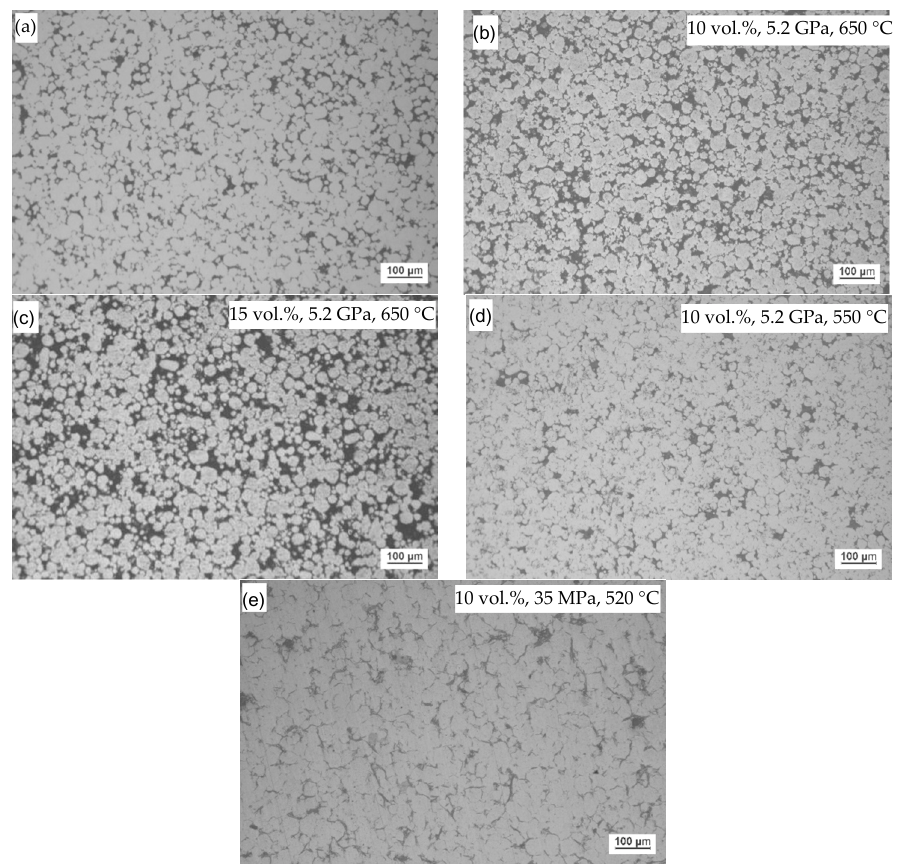
Figure 2. Optical images of the sintered G/6061Al with ( a ) 5 vol.%, ( b ) 10 vol.% and ( c ) 15 vol.% graphite at 5.2 GPa and 650 °C and ( d ) that with 10 vol.% at 5.2 GPa and 550 °C, or ( e ) at 35 MPa and 520 °C.